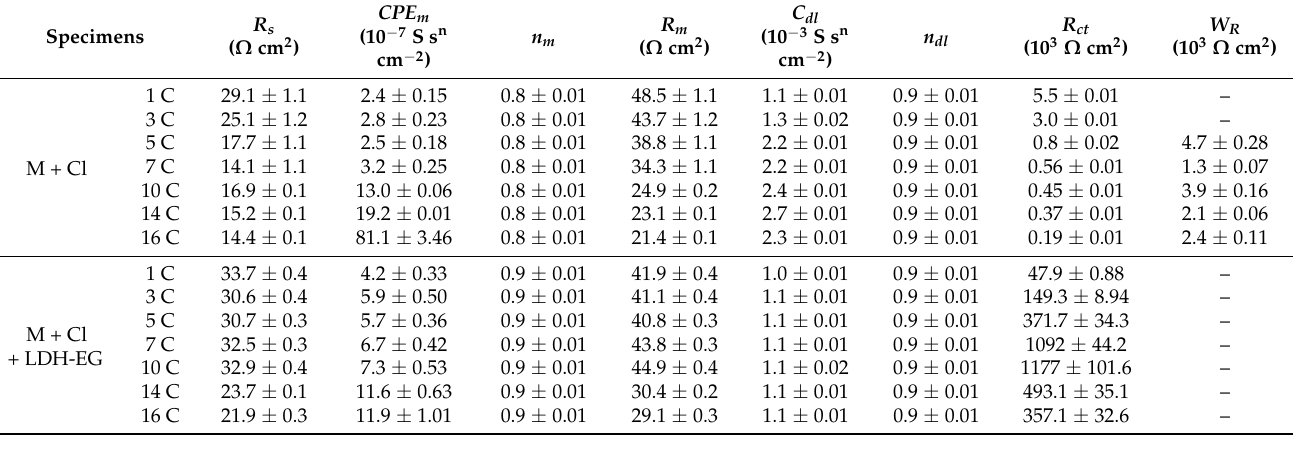
Table 2. Fitted parameters for EIS spectrum depicted in Figure 9.